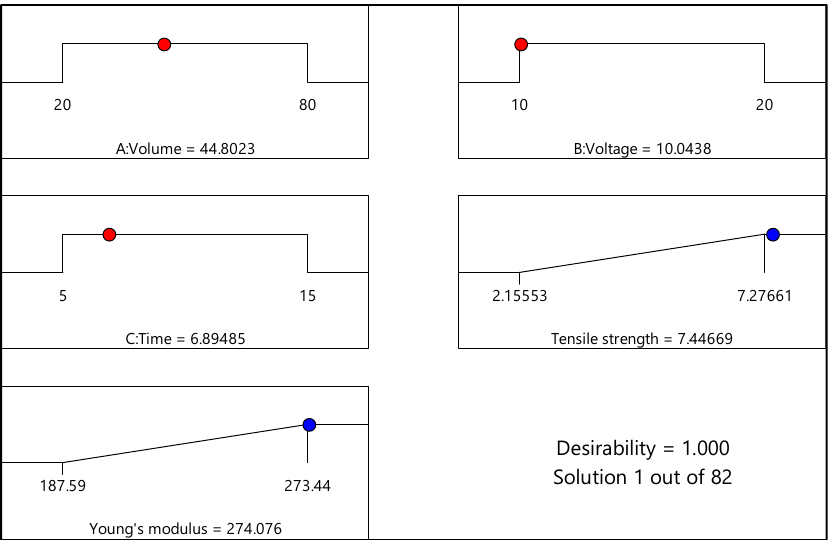
Figure 12. Ramp chart for statistically optimized factors and response for experimental design of 20% and 80% water.